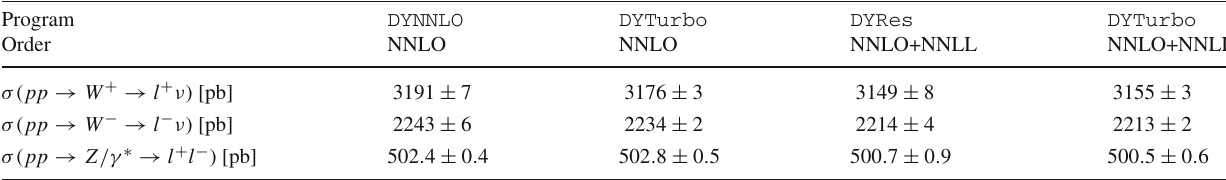
Fig. 8 Comparison of DYRes and DYTurbo cross sections at space W + and W − production, and fiducial Z -boson production Table 1 Comparison of NNLO and NNLO+NNLL cross-section results at